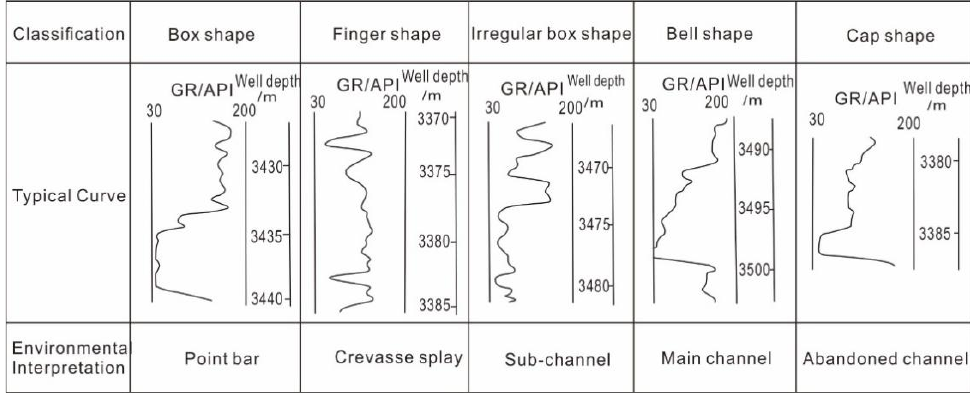
Figure 7. Logging characteristics of different sedimentary microfacies.